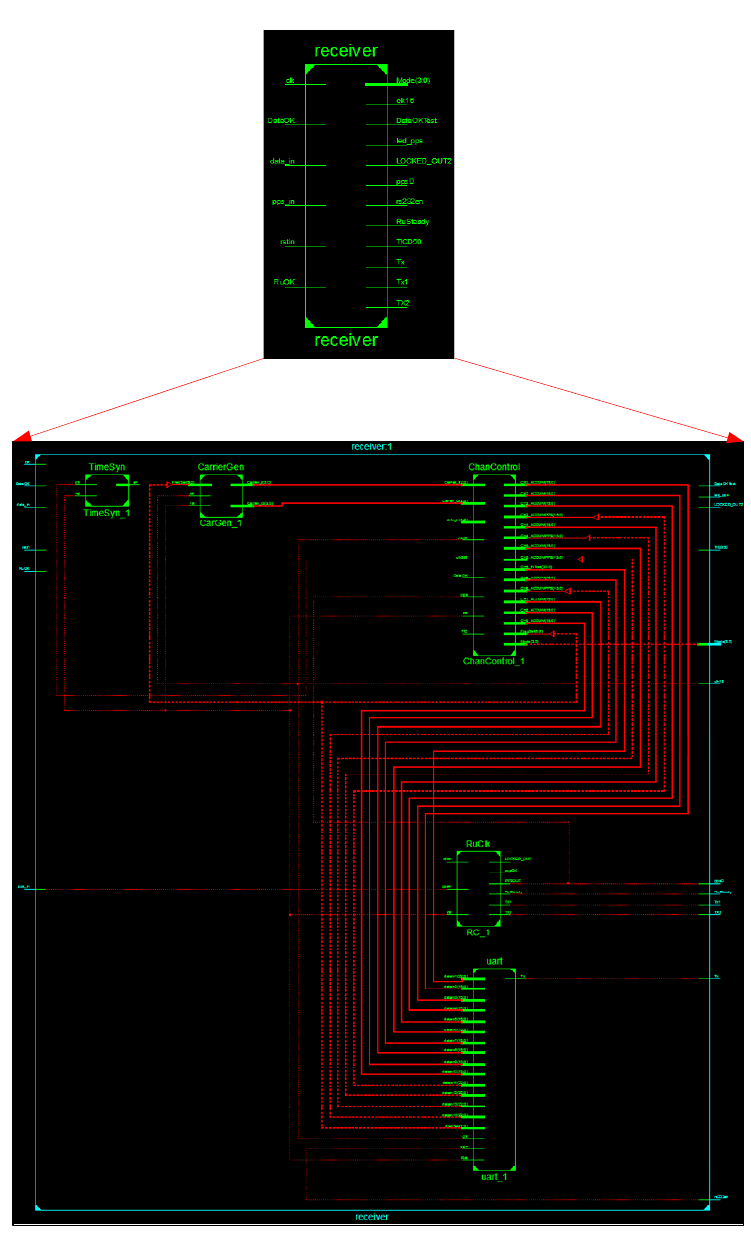
Figure 10. The schematic diagram of the baseband signal processing module at the RTL level.